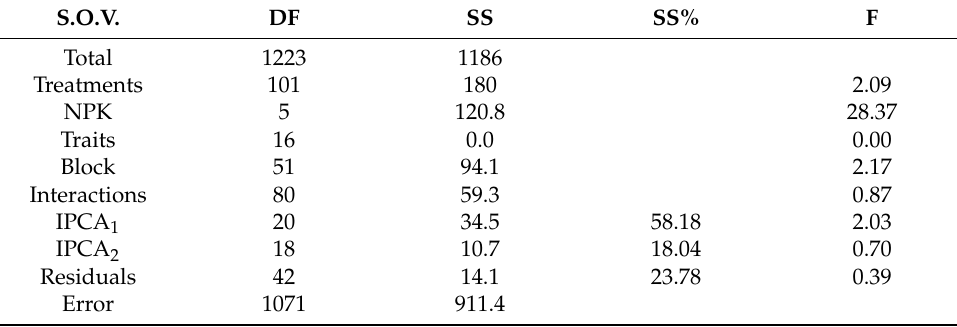
Table 4. Variance analysis by AMMI model FAO340 in six NPK